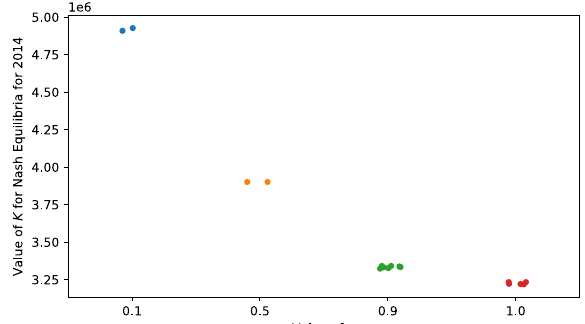
Figure 6. Changes in the distribution of interior Nash Equilibria as the value of γ changes. As γ increases, the value of K that leads to a Nash Equilibrium decreases.